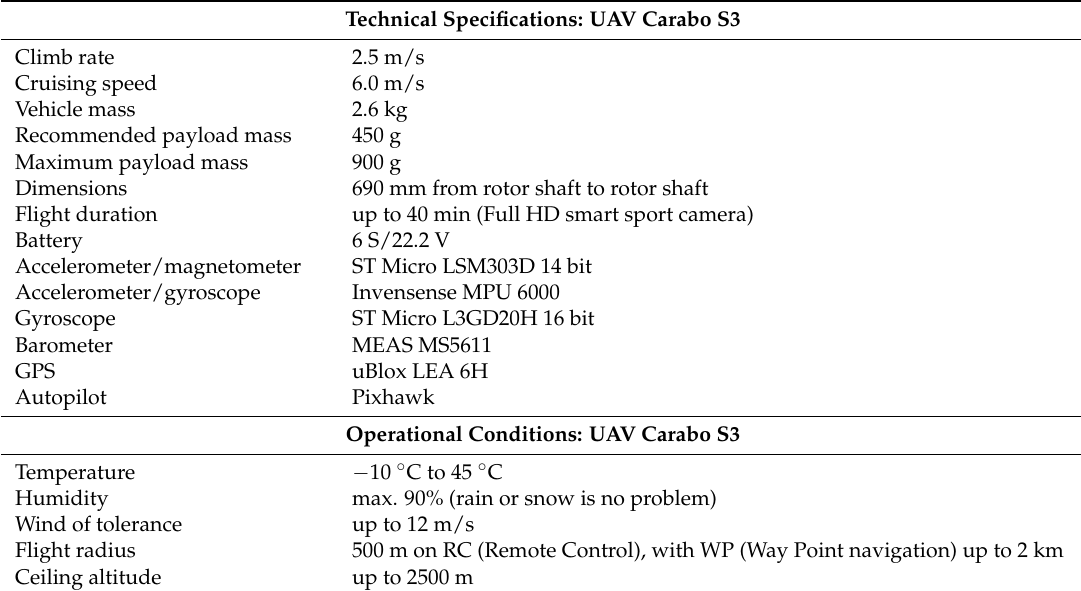
Table 1. Technical specifications and operational conditions: UAV Carabo S3.